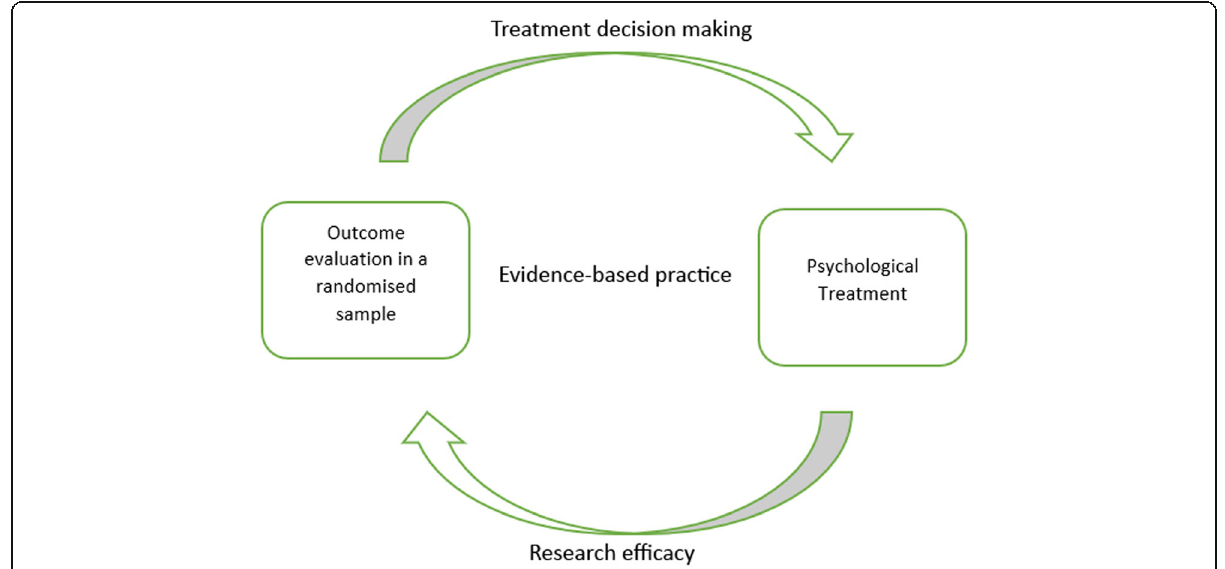
Fig. 1 Typical knowledge generation process in evidence – based practice